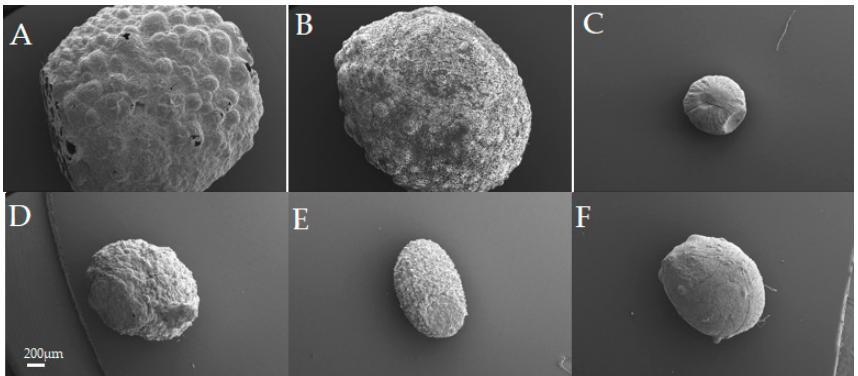
Figure 3. The scanning electron microscope (SEM) images of gastric and intestinal beads: ( A – C ) BSA-ALG-24 h, BSA-ALG-0 h, and ALG gastric beads respectively. ( D – F ) BSA-ALG-24 h, BSA-ALG-0 h, and ALG intestinal beads, respectively (scale bar 200 μ m).